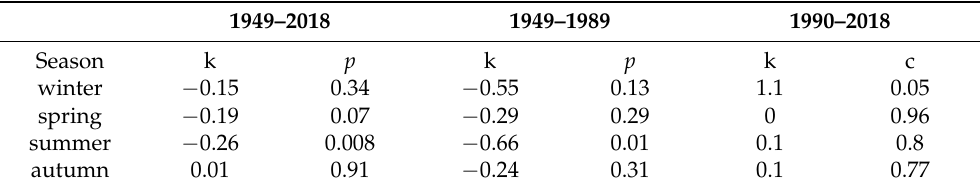
Table 3. Linear annual trends, k [%/(10 years)], and their significance, p , for the average seasonal probability of air particles transport from the deserted lands of Kalmykia to the Moscow region